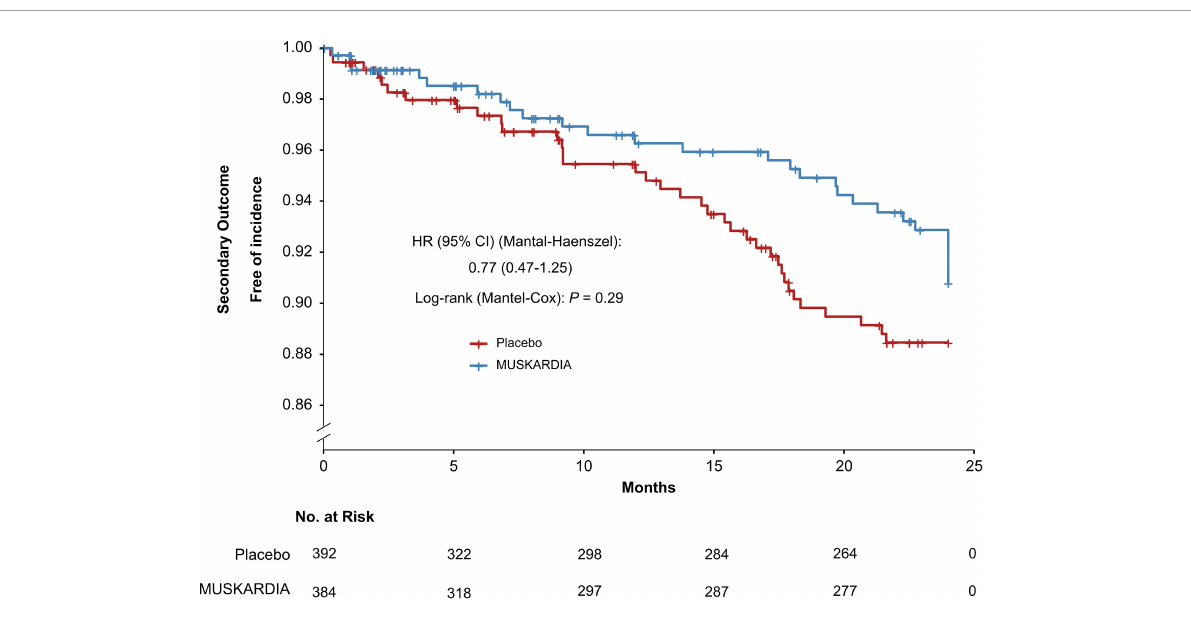
FIGURE2 Kaplan–Meier curve analysis of the secondary composite outcome. Hazard ratio = 0.77 (95% confidence interval: 0.47–1.25), P =